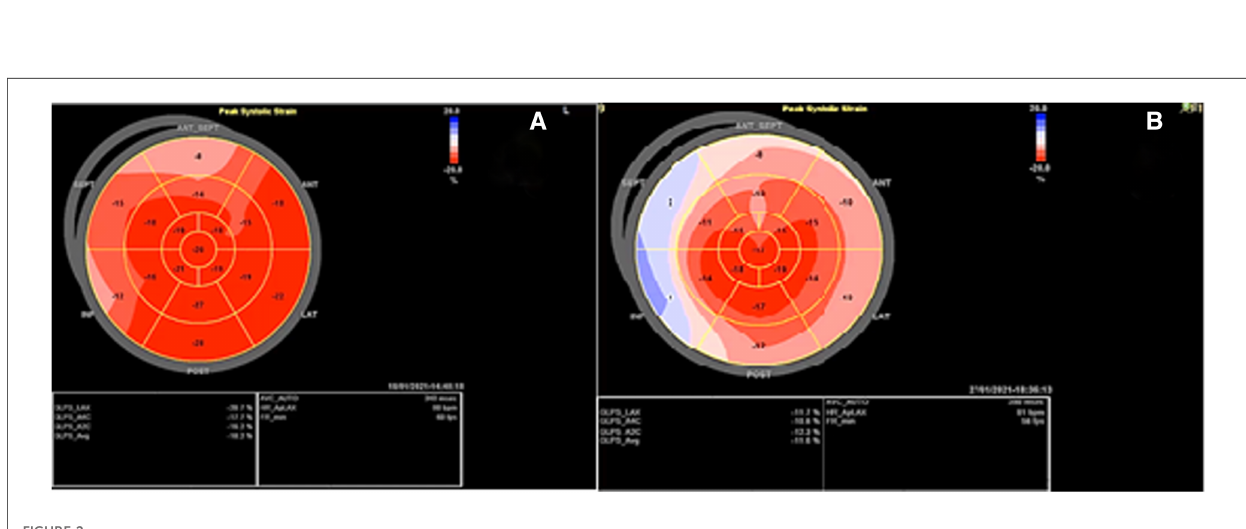
FIGURE 2 Speckle tracking echocardiography before and after the radiotherapy course: ( A ) Before radiotherapy, which showed a global longitudinal strain of − 18.2% with myocardial performance impairment in the bases of inferior, septal, and anteroseptal walls a week. ( B ) After radiotherapy, which showed GLS: − 11.2% with evidence of severe myocardial performance impairment accompanied by relative apical